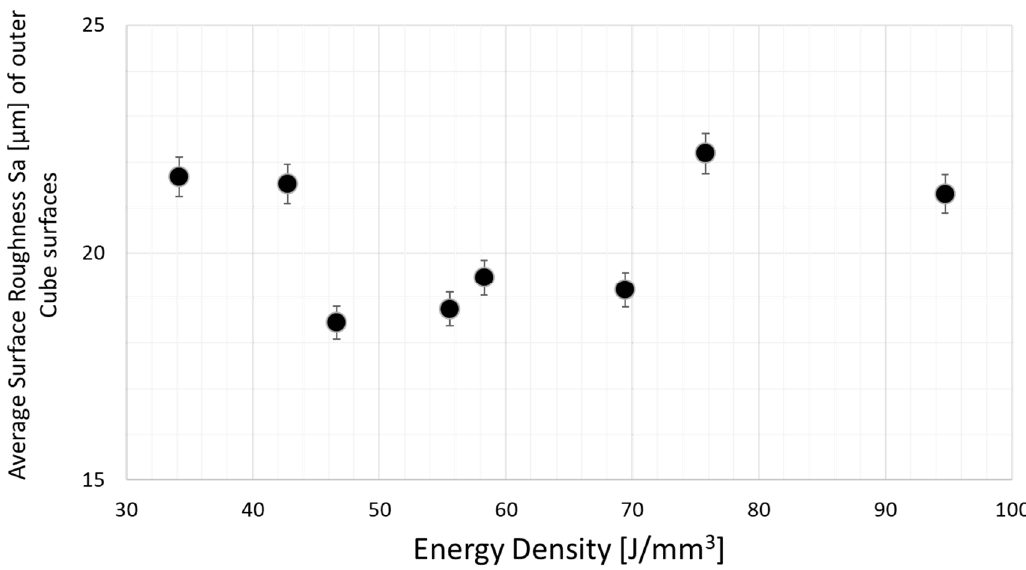
Figure 6. Roughness value Sa plotted against energy density for outer cube surfaces.